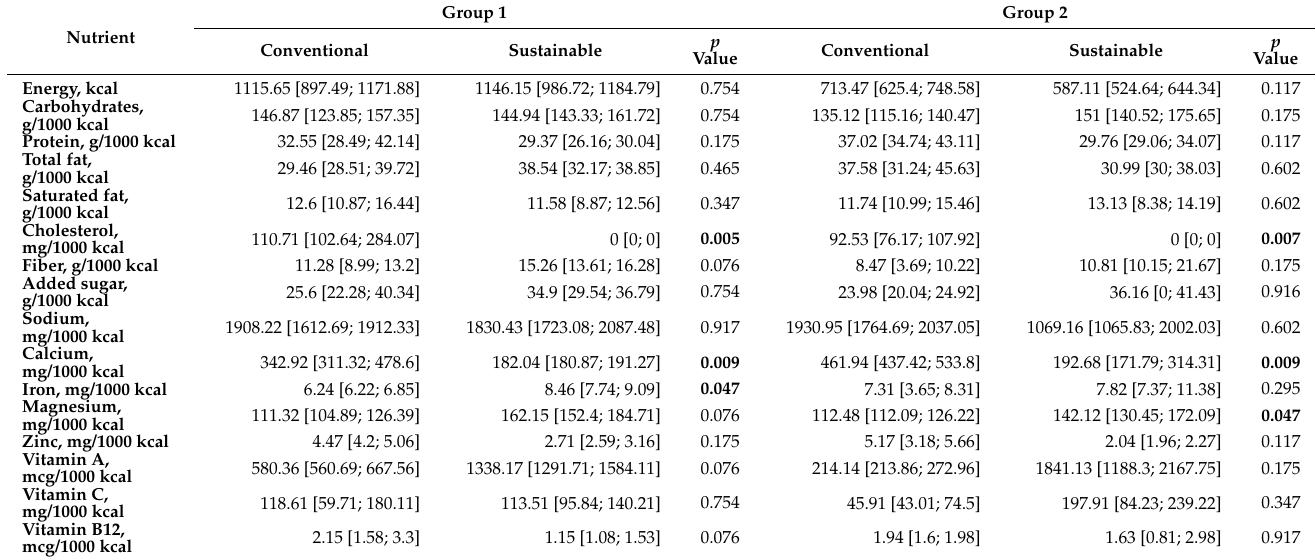
Table 2. Nutritional content, as median ( p 25; p 75), of the conventional and sustainable food menus, according to the age